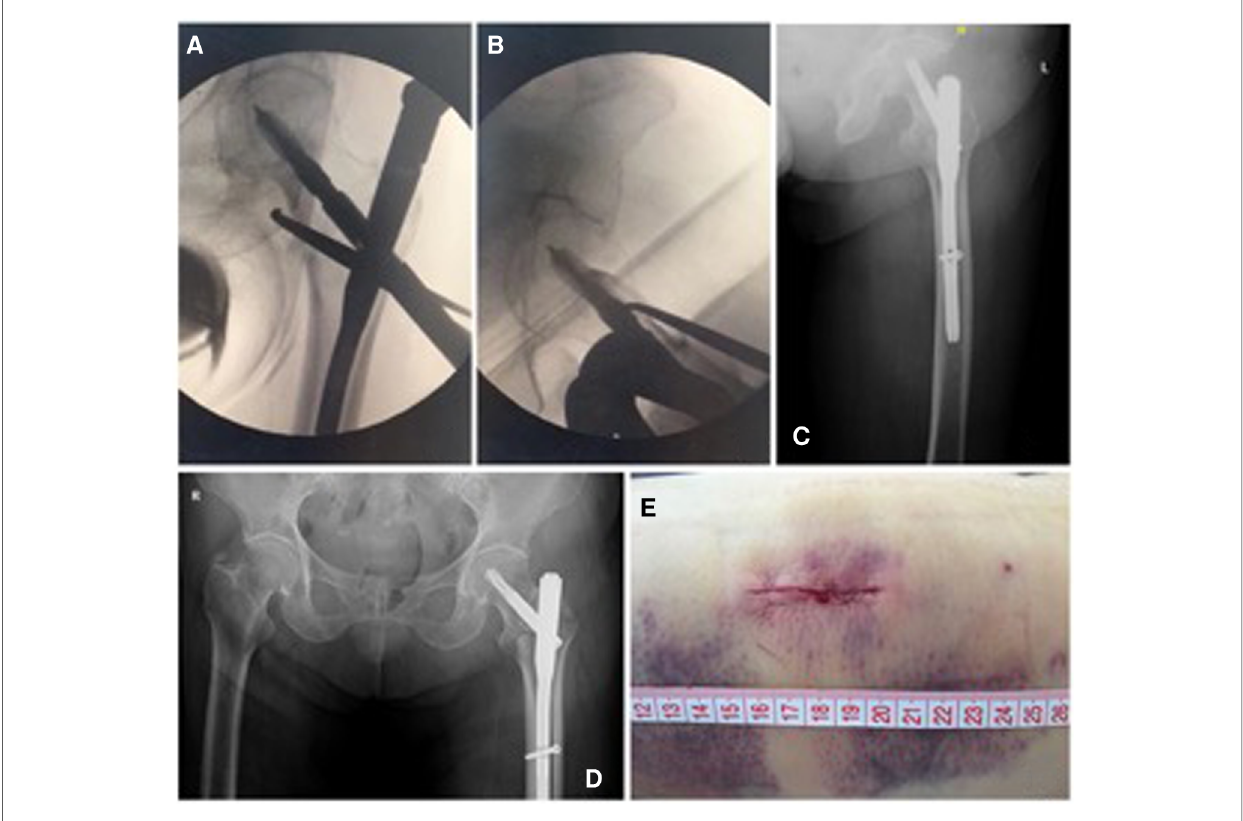
FIGURE 4 Routine maneuvers during nail fi xation. ( A,B ) Anteroposterior and lateral views of the anatomical reduction and satisfactory fi xation by PFNA. ( C,D ) Postoperative radiographs showing perfect fi xation of the intertrochanteric fracture. ( E ) A minimal incision was used for reduction of the medial arch fragments and helical blade insertion.